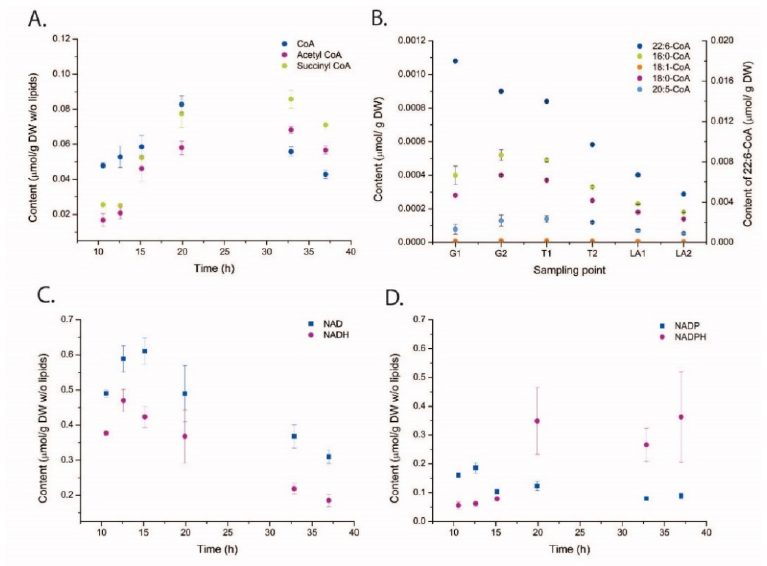
Figure 5. Time series absolute concentrations in μmol/g DW units of SC-CoAs ( A ), LC-CoAs ( B ), NAD (H) ( C ), and NADP(H) ( D ). Metabolites are presented. The data are presented with averaged and standard deviation among four technical replicas. LC-CoA samples are from another biological replica and the samples are aligned to cultivation phases along the time axis (G—growth; T—transition; LA—lipid accumulation).